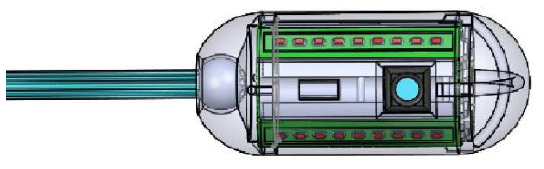
Figure 12. Complete intelligent capsule design.